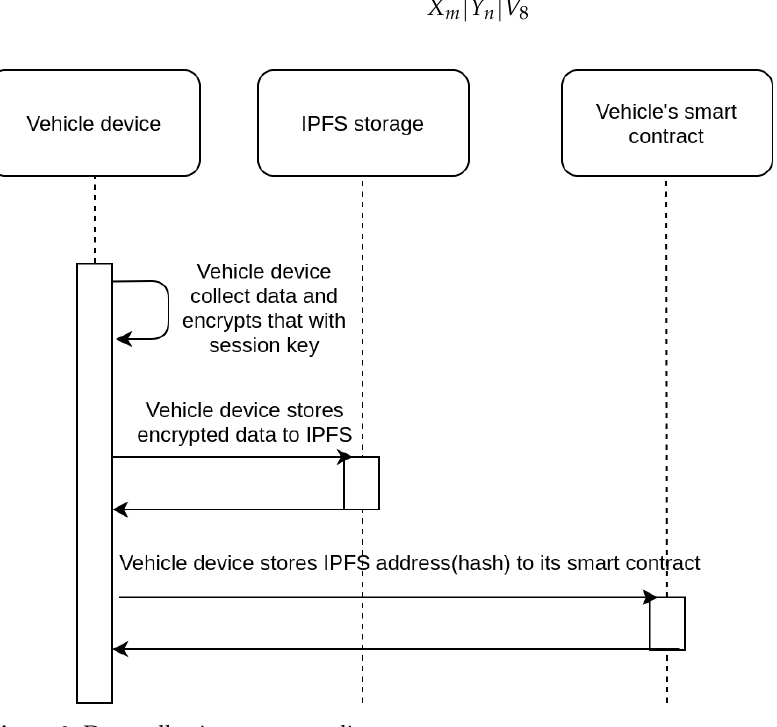
Figure 2. Data collection sequence